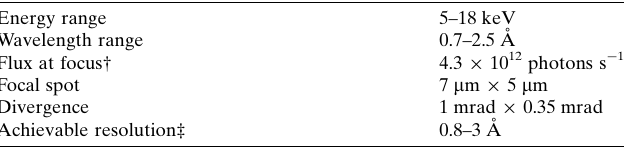
Table 1 AMX key performance parameters – specifications of the AMX photon delivery system and achievable